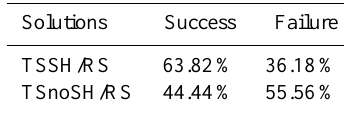
Table 6. Three sets of profiles divided by the